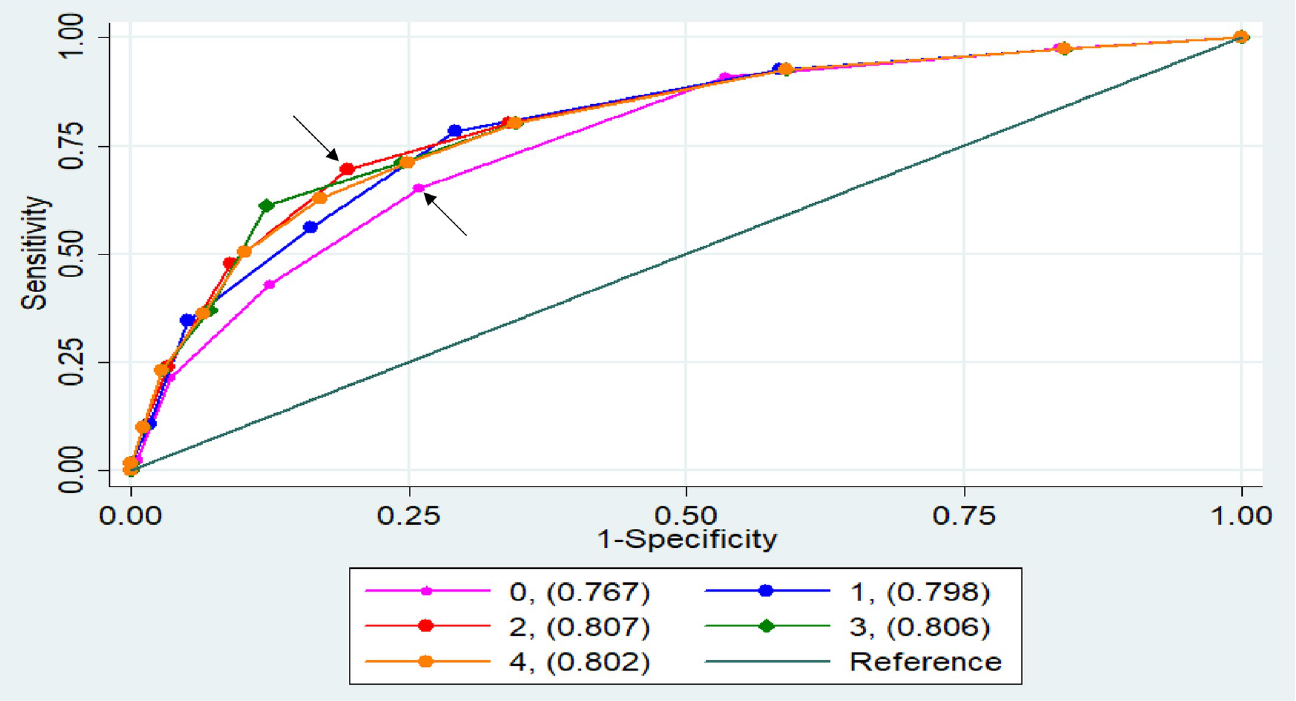
Fig 1. ROC curves for simple scoring systems to predict culture-positive TB among patients undergoing TB evaluation. Each score consists of the number of TB symptoms (0 to 6) reported by the patient, with additional points added if the patient had an underweight BMI. The legend shows the number of points added for underweight BMI (0 to 4), with the resulting c-statistic provided in parentheses. For example, having > = 3 symptoms had a sensitivity of 65% and a specificity of 74% for TB (lower arrow), but having a cutoff > = 4 in the combined score which added two points for underweight (a total which could be achieved by having at least four symptoms, or by having at least two TB symptoms and being underweight) had both a higher sensitivity of 69% and a higher specificity of 81% for TB (upper arrow).